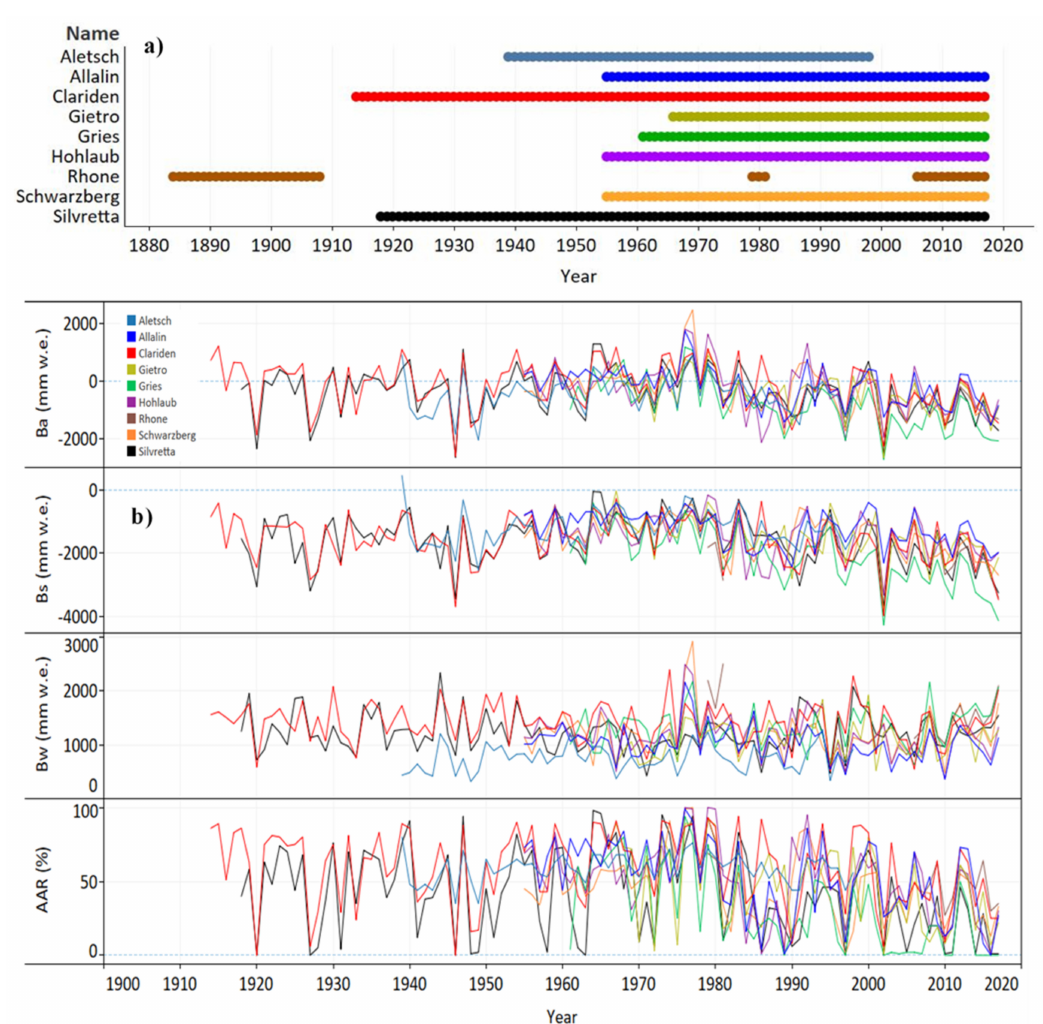
Figure 2. Data coverage of annual mass balances (Ba) ( a ) and the time series of annual mass balance (Ba), summer mass balance (Bs), winter mass balance (Bw), and accumulation area ratios (AAR) for the selected glaciers from 1914 to 2017 ( b ) (Source: